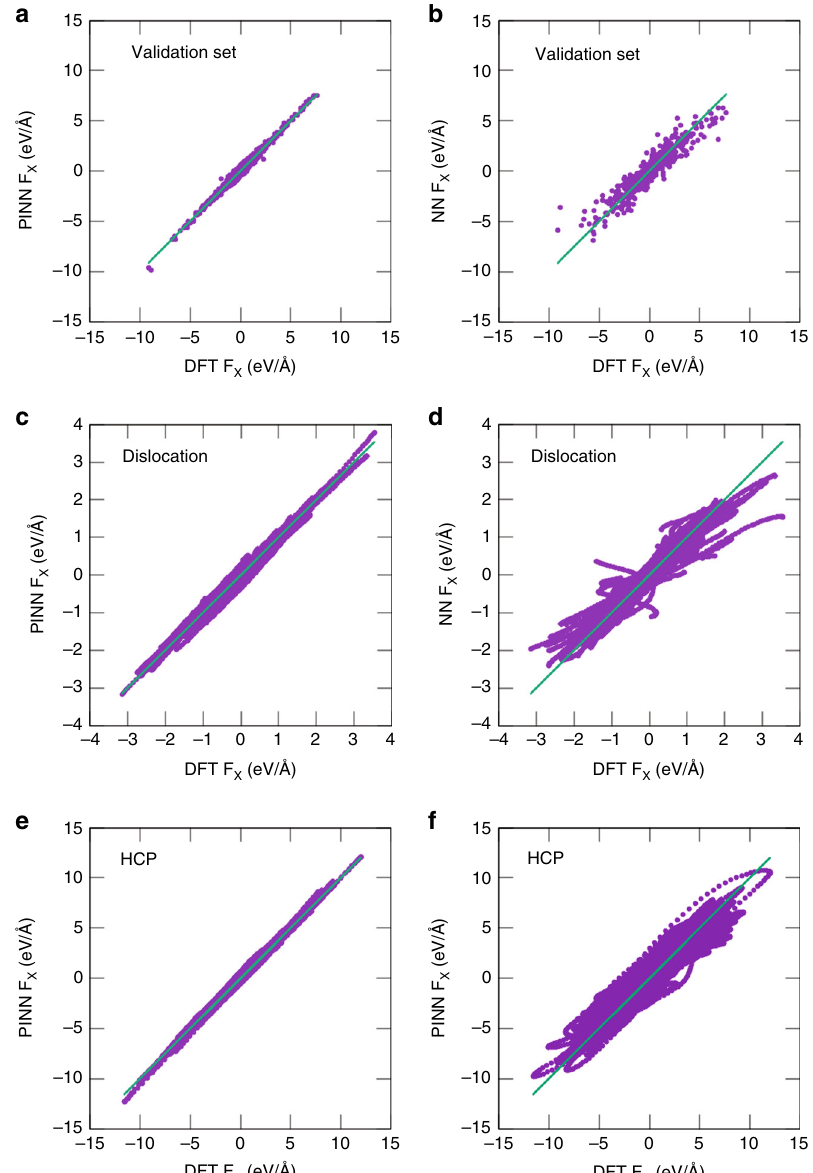
Fig. 7 Testing of atomic force predictions. The x -component of atomic forces for a , b validation database, c , d edge dislocation in NVE MD simulations starting at 700 K, and e , f HCP Al in NVT MD simulations at 300, 600, 1000, 1500, 2000, and 4000 K. The forces predicted by the PINN ( a , c , e ) and NN ( b , d , f ) potentials are compared with DFT calculations from refs. 20,21 . The straight lines represent the perfect fi t. See Supplementary Figs 11 – 13 for all components of the